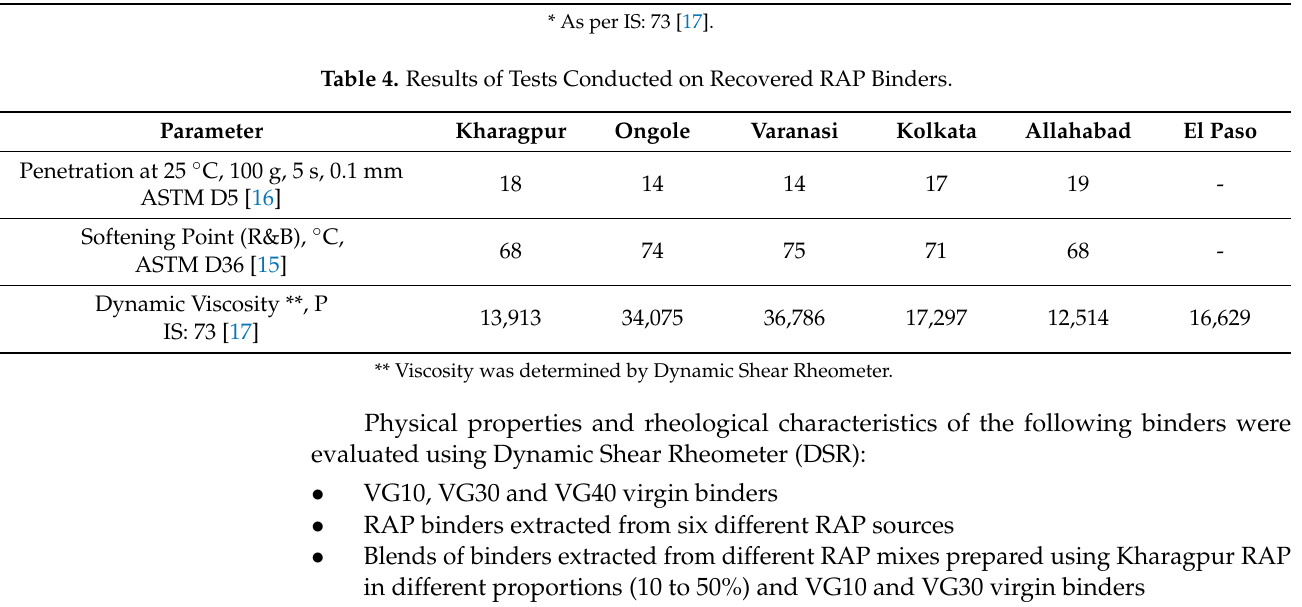
Table 5. Results of Tests Conducted on Recovered RAP Binders .